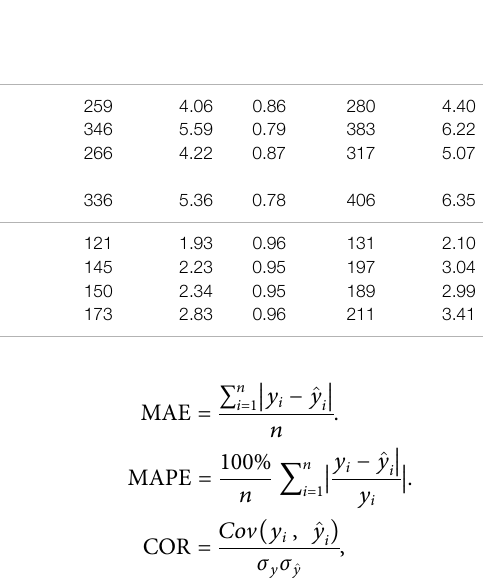
Mean absolute absolute error percentage (MAE) error